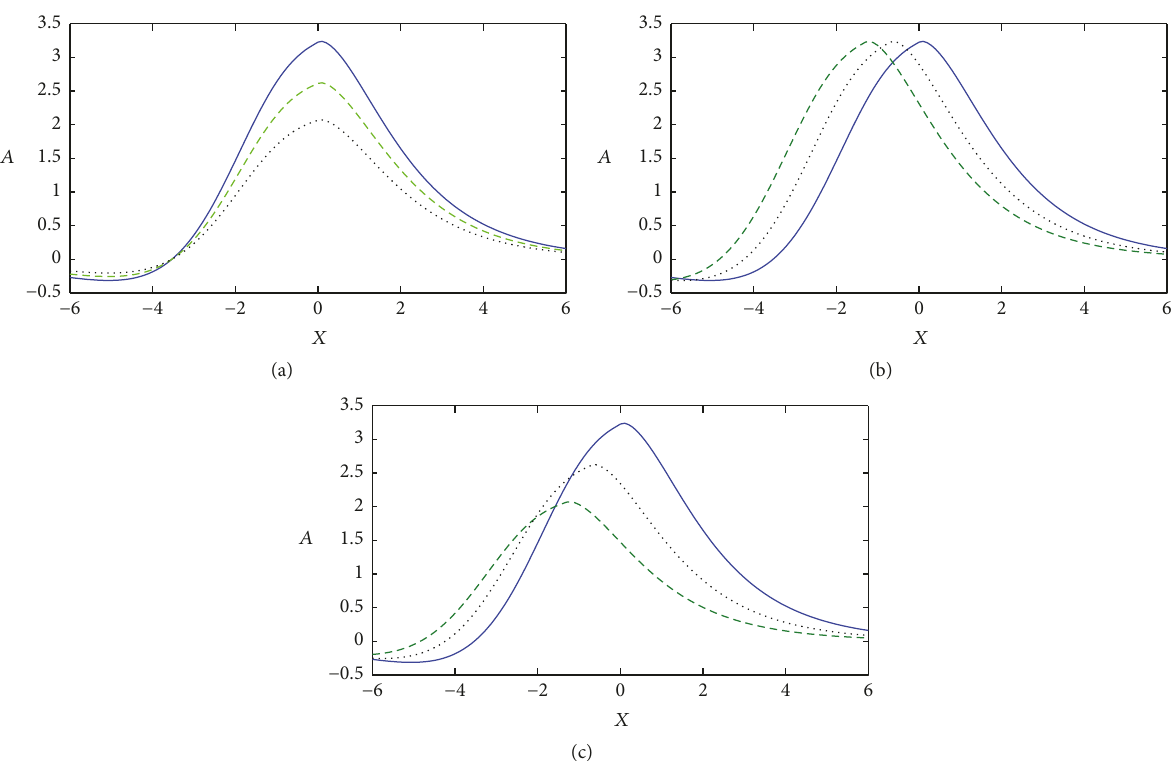
Figure 1: Plots for the evolution of the one-soliton solution of ion-acoustic solitary waves with (a): 𝑡 = 1 , 𝑎 1 = 1 , 𝑎 3 = 0 , 𝑎 4 = 1 , 𝑘 1 = 1 , 𝑟 = 0.4 , 𝑞 = 0.4 , 𝛼 = 0.8 , 𝛽 = 1 , 𝛾 = 1 , 𝜔 = 2 ; (b): 𝑡 = 3 , 𝑎 1 1 (c): 𝑡 = 5 , 𝑎 1 = 1 , 𝑎 3 = 0 , 𝑎 4 = 1 , 𝑘 1 = 1 , 𝑟 1 = 0.4 , 𝑞 1 = 0.4 , 𝛼 = 0.8 , 𝛽 = 1 , 𝛾 = 1 , 𝜔 = 1.5 , and 𝑎 2 = 0.1 (solid line), 𝑎 2 = 0.09 (dotted line), 𝑎 = 0.08 (dashed line). 2